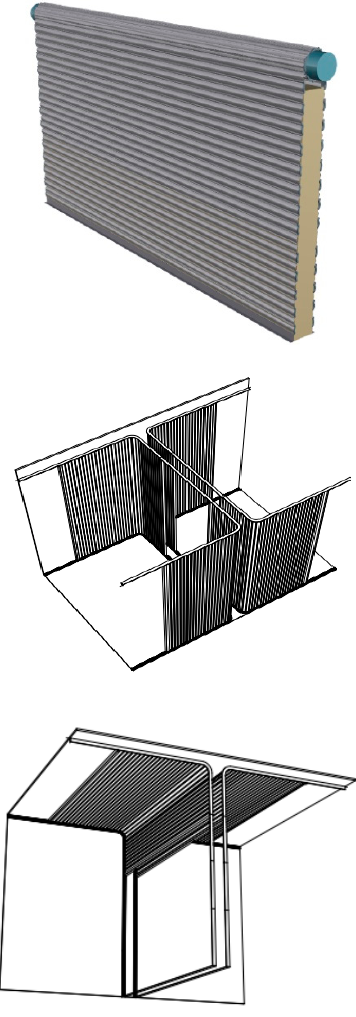
Figure 17. Deployment of barriers to contain and control floodwater/fire progression.